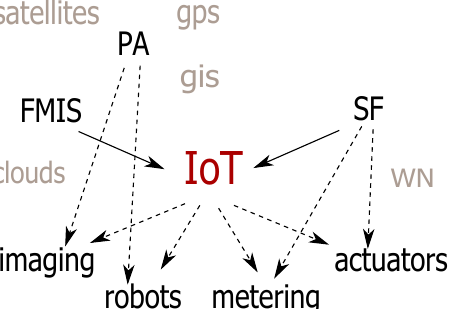
Figure 1. Major recent technologies involved in Agriculture 5.0. IoT—Internet of Things; PA— Precision Agriculture; FMIS—Farm Management Information Systems; WN—Wireless Networks; SF—Smart Farming; gis—geographic information systems; GPS—Global Positioning